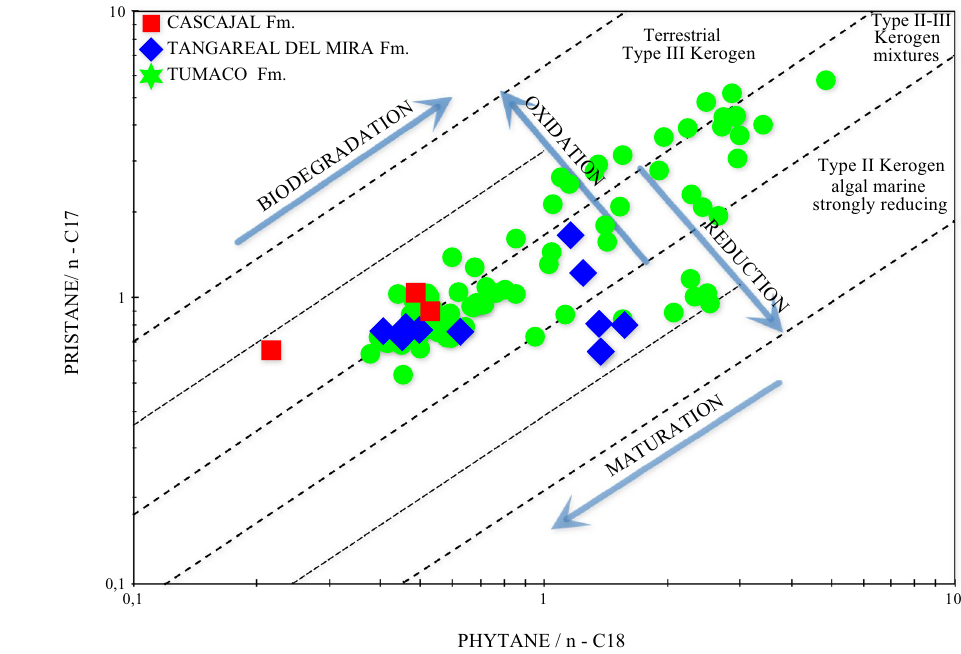
Fig. 11 Geochemical correla- tion between Isoprenoids/ n - alkanes showing the sources and depositional environment of the organic matter in the Tumaco-1-ST-P, Tumaco